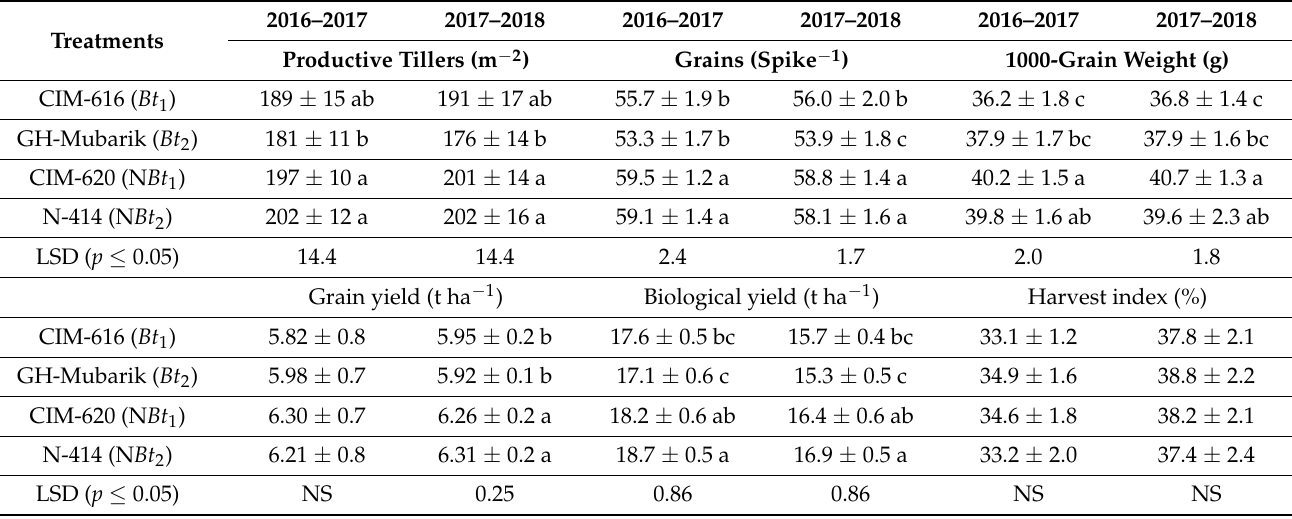
Table 6. Yield-related parameters of wheat crop sown after the harvest of transgenic and non- transgenic cotton